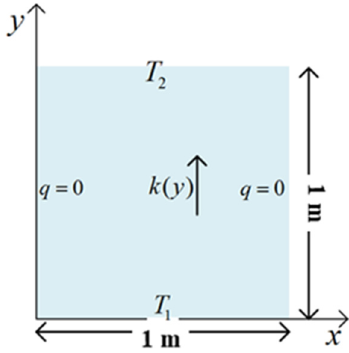
Figure 7. Steady-state heat conduction model of the FGM plate.